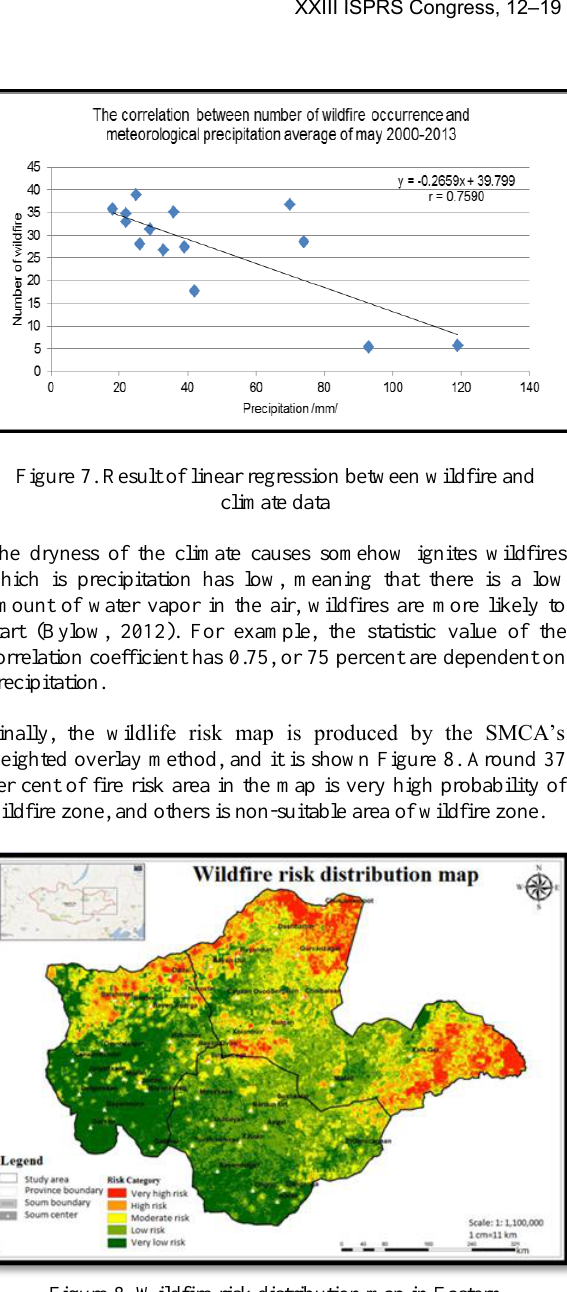
Figure 8. Wildfire risk distribution map in Eastern part of Mongolia